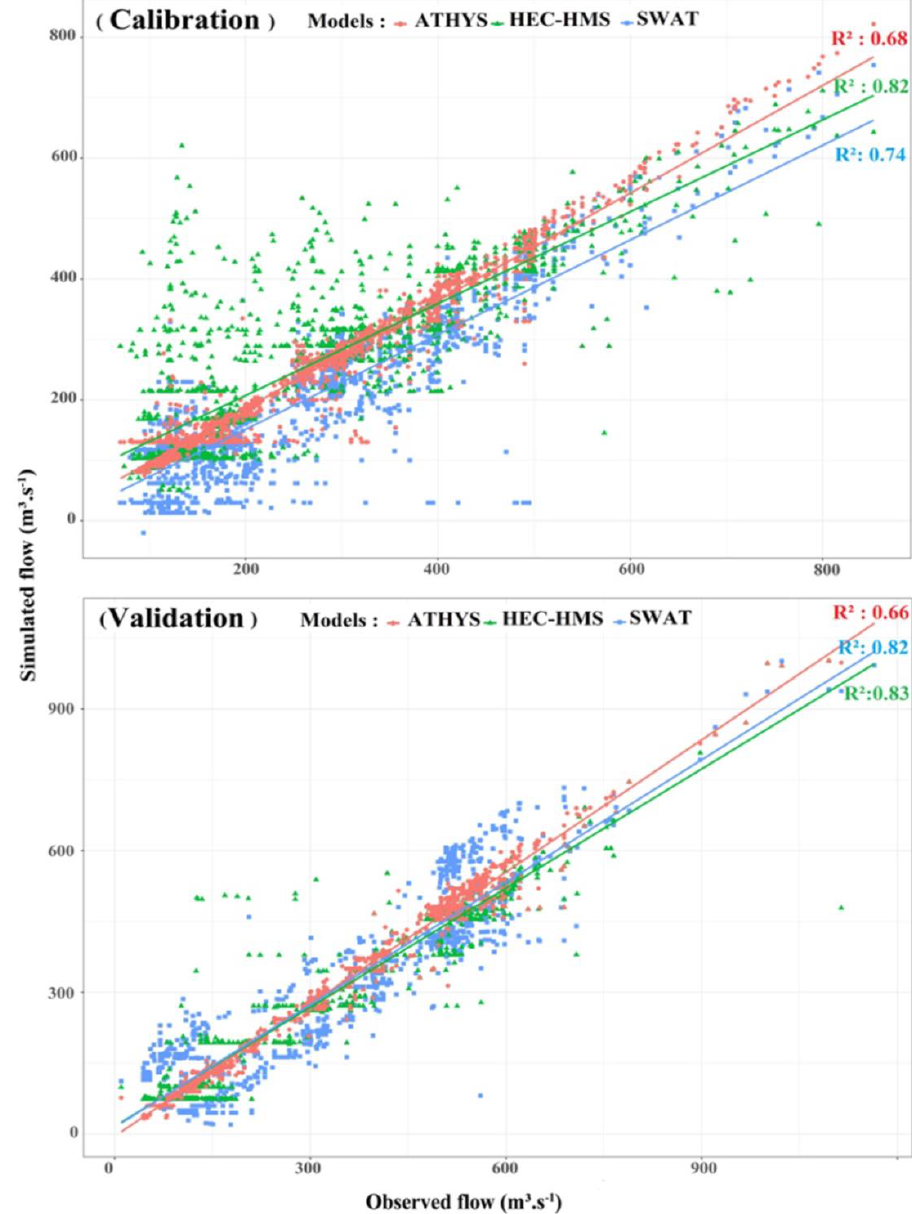
Figure 5. Scatterplots demonstrating the coefficient of determination ( R² ) between observed and simulated flows by different hydrological models during the calibration and validation periods.